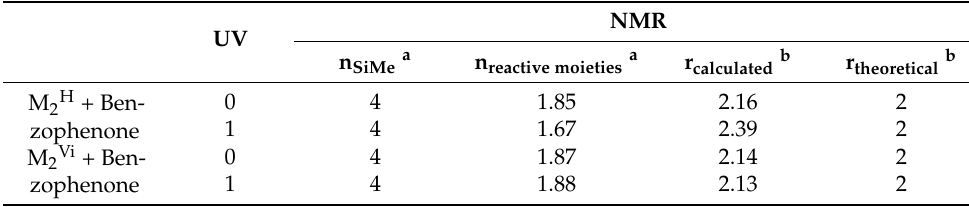
Table 2. NMR analyses for model